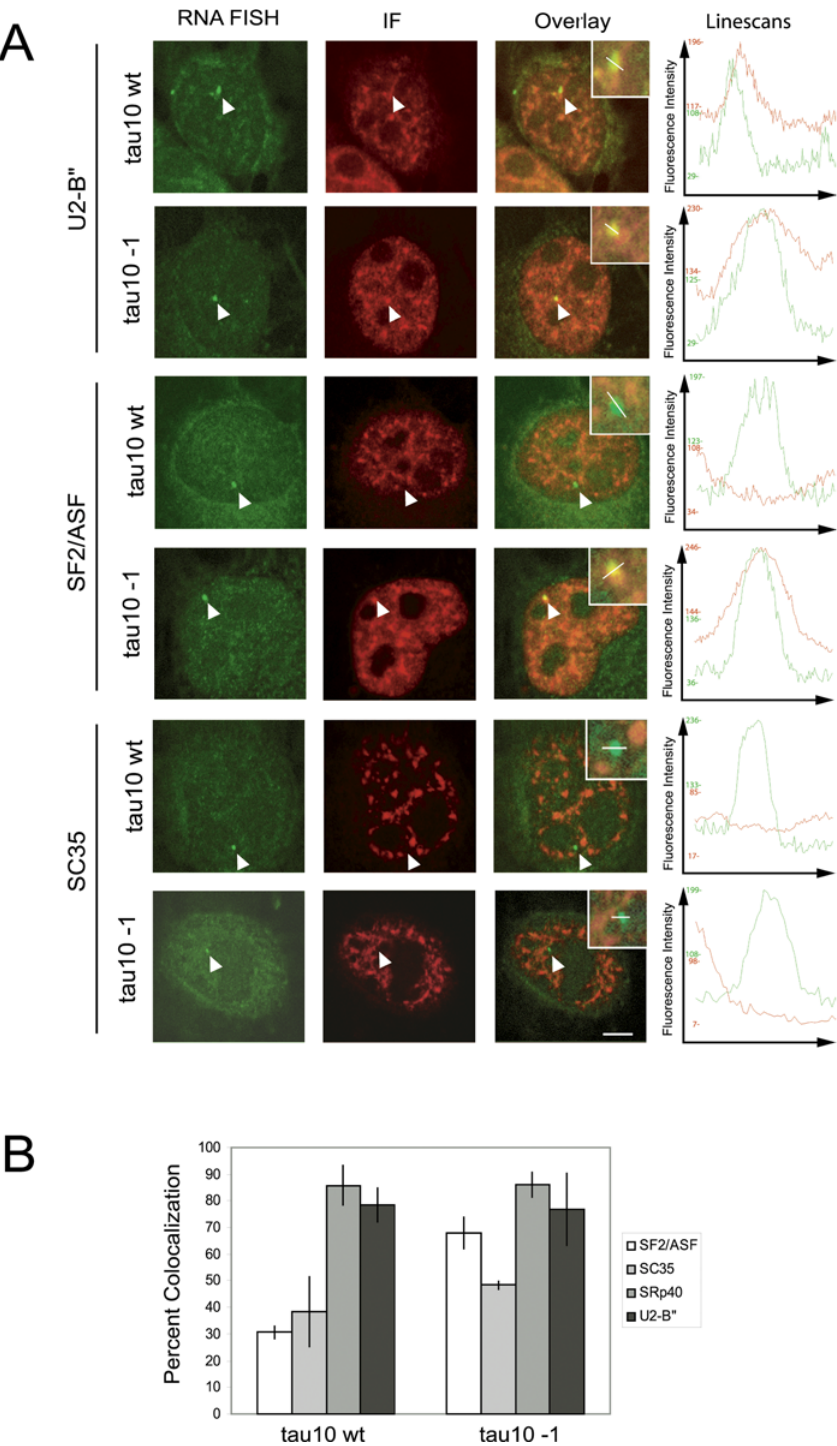
Figure 2. Differential Recruitment of Endogenous Pre-RNA Splicing Factors to Alternatively Spliced Transcripts (A) Recruitment of splicing factors to tau transcription sites detected by combined RNA-FISH using specific probes against the tau minigene (green) and IF microscopy with specific anti-splicing factor antibodies (red). Arrowheads indicate tau transcription sites. All associations were confirmed by linescan analysis. Scale bar ¼ 2.5 l m. (Inset: higher magnifications of the transcription site) Lines indicate the location of the linescans. (B) Quantitation of percentage of cells with colocalization of tau RNA-FISH and splicing factor signals. Values represent averages from at least 100 transcription sites from at least three experiments 6 SEM. DOI: 10.1371/journal.pbio.0030374.g002